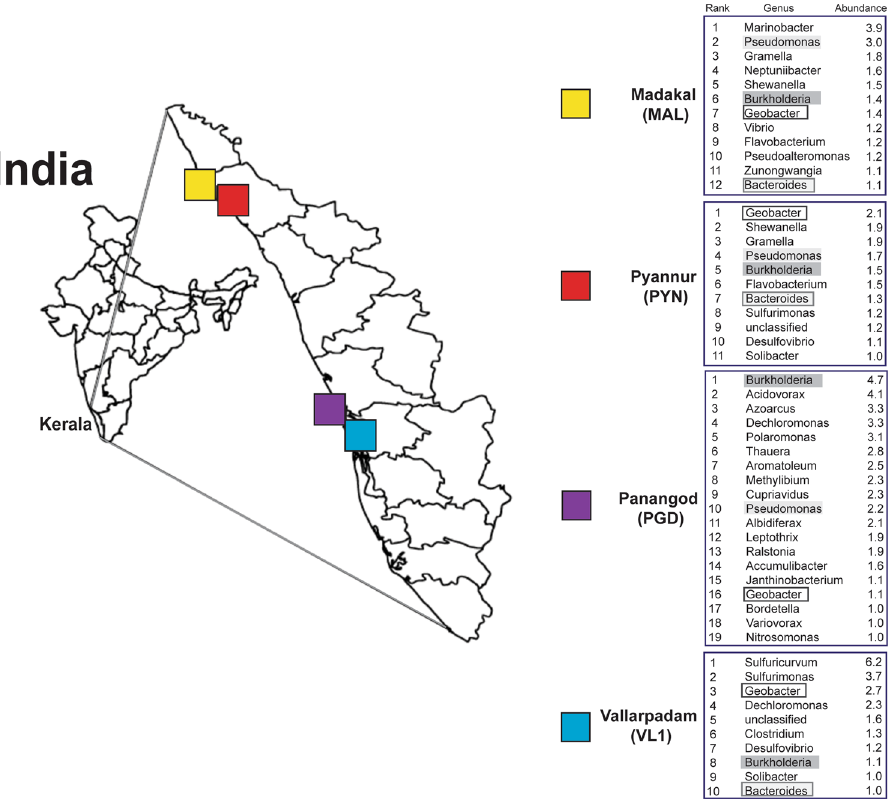
Figure 4. Geographic locations and diversity in the sampling sites in the mangrove ecosystem of Kerala, India. Genera with more than 1% of the mapped reads are listed, with their rank and indications of their abundance are shown, and organisms shared across sampling locations are indicated by shading or boxes. (Image source: http://www.d-maps.com/carte.php?num_car = 24853&lang = en andInkscapev0.92 was used for sample site labelling).